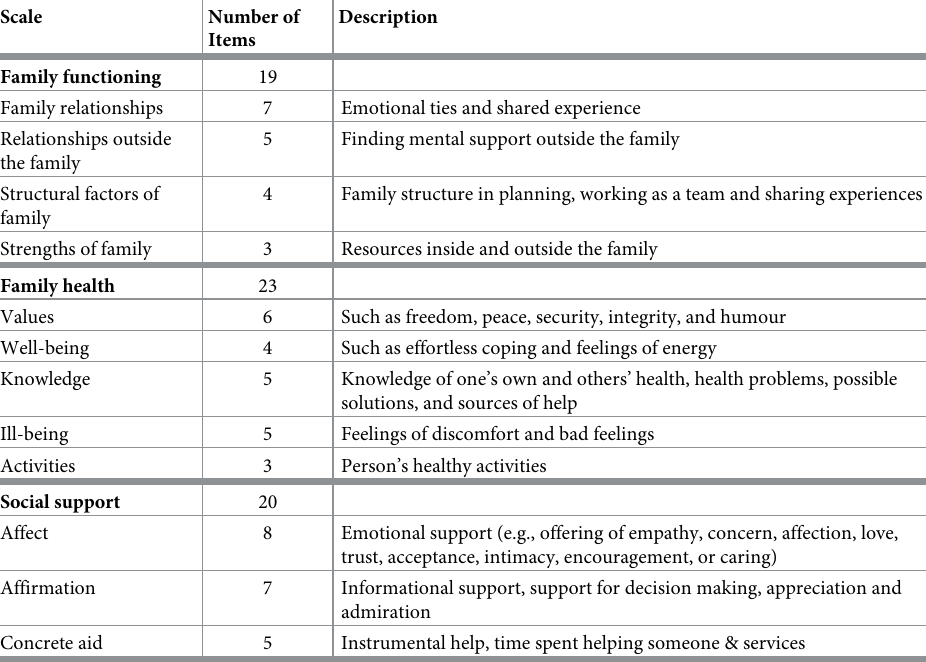
Table 1. FAFHES questionnaire’s subscales and